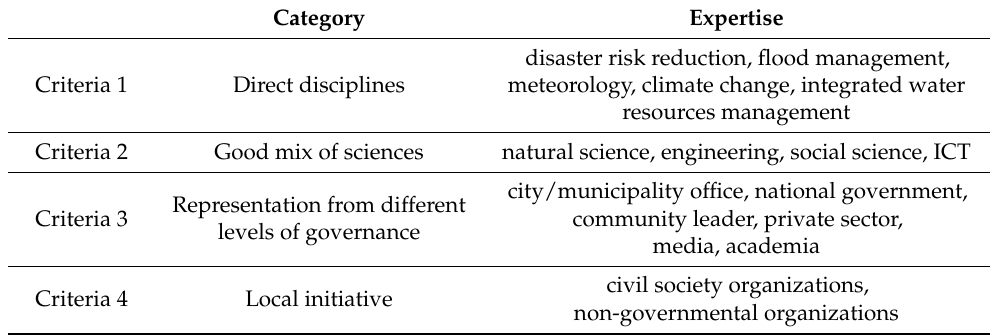
Table 1. Criteria for gathering Facilitator candidates from different disciplines and sectors in the